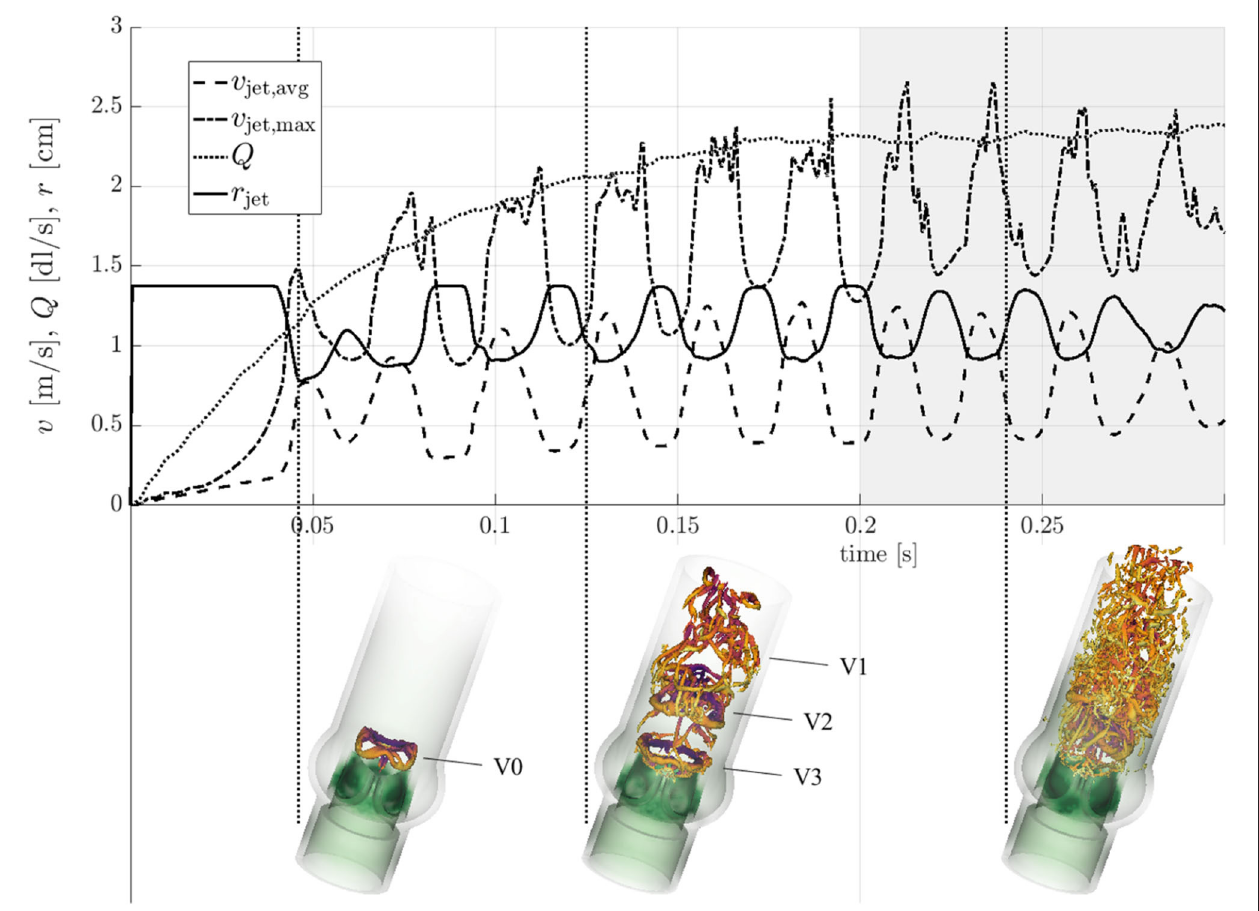
FIGURE 5 | Transient evolution of the characteristic quantities form Table 1 . Vortical structures (orange λ 2 -isosurfaces, Jeong and Hussain, 1995) are shown at time instances t = 0.046s, 0.125s, and 0.24s (indicated by vertical dotted lines).